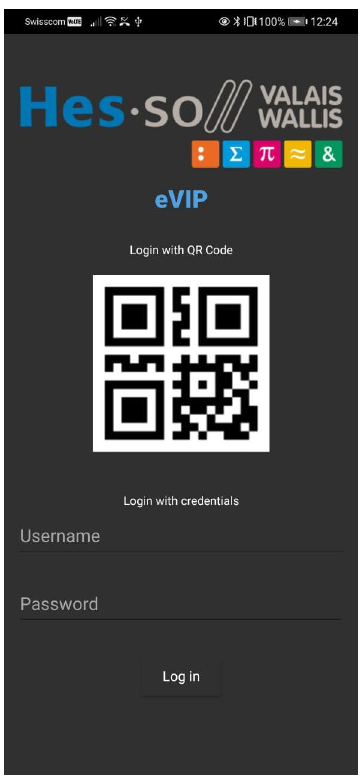
Figure 10. Login